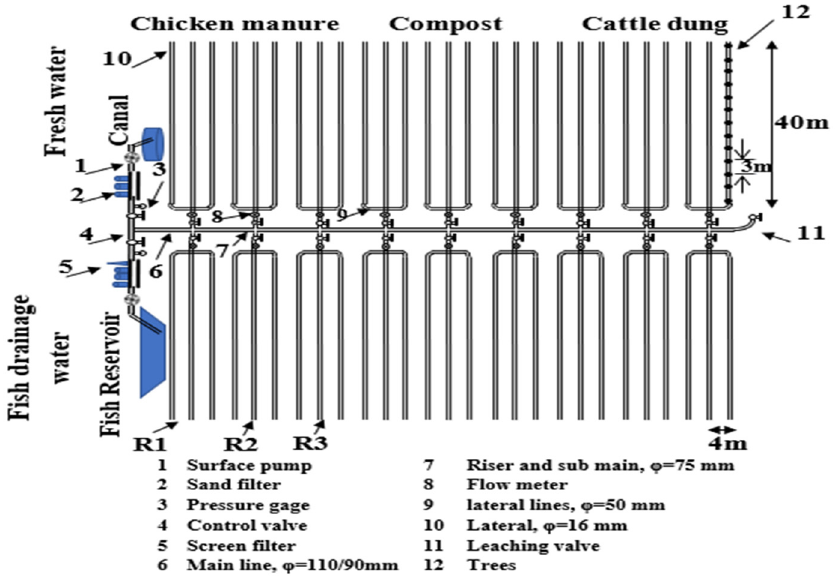
Figure 2. The layout of the drip irrigation